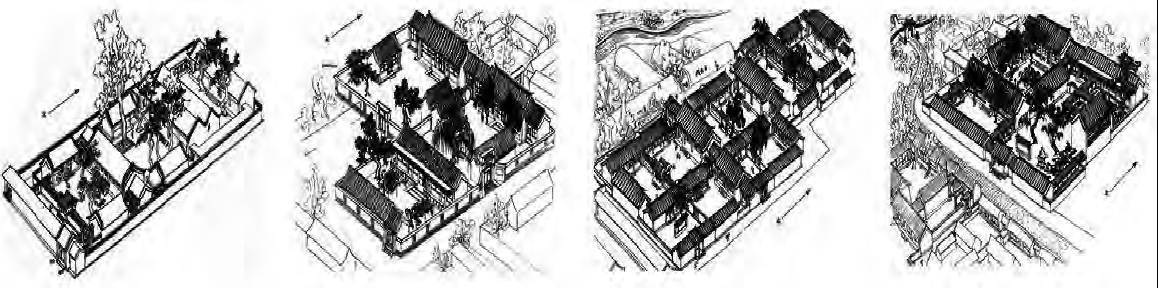
Figure 1. Typology of traditional Chinese house with courtyards. Source: Wang,